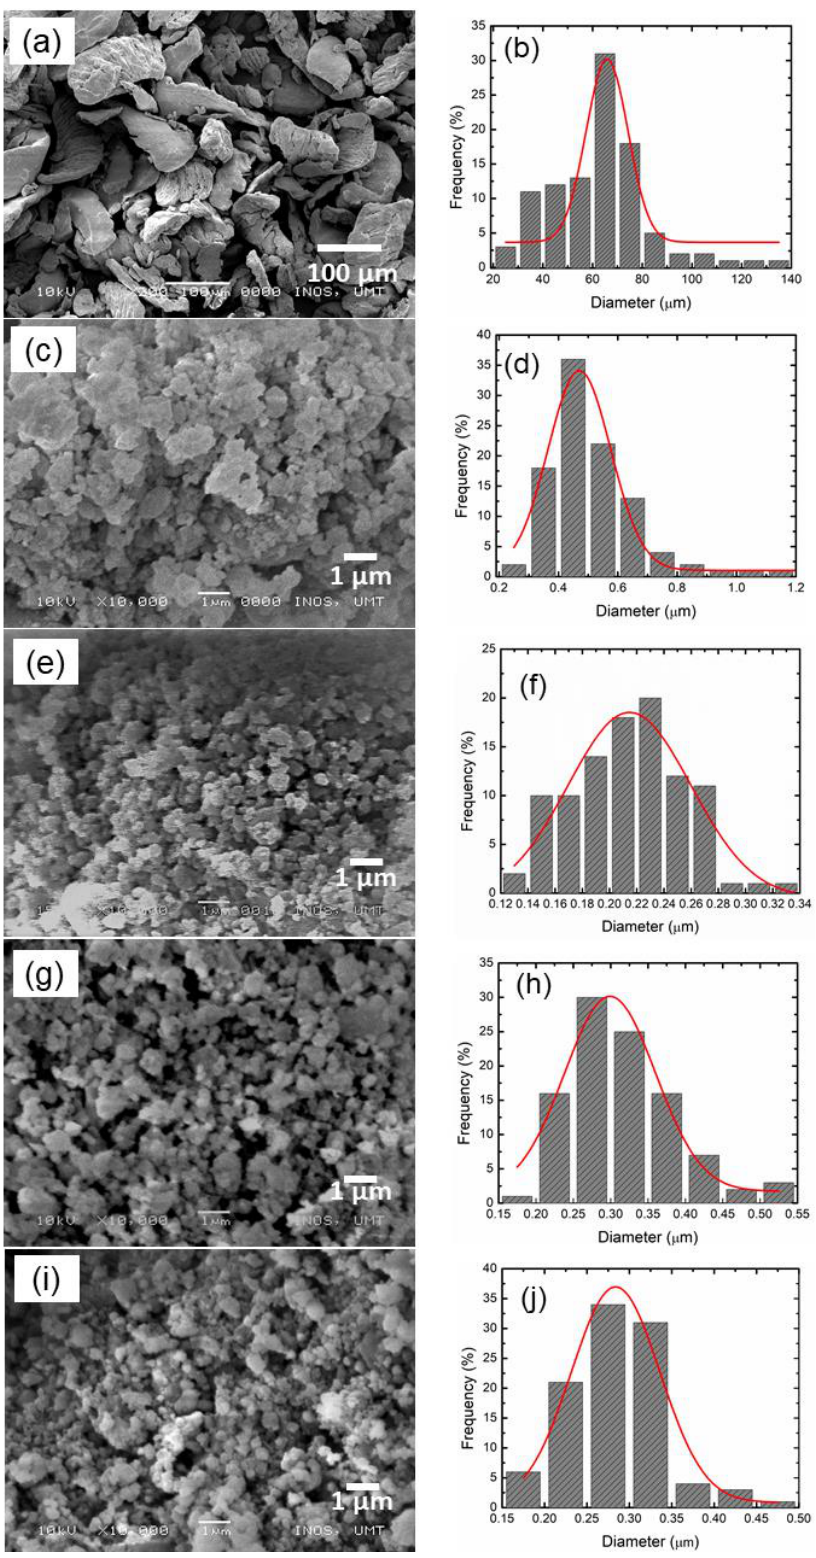
Figure 7. SEM images and particle size distribution histogram of commercial MgH 2 ( a , b ), as-milled MgH 2 ( c , d ), MgH 2 + 10 wt.% CoTiO 3 after milling ( e , f ), MgH 2 + 10 wt.% CoTiO 3 after absorption at 200 °C ( g , h ), and MgH 2 + 10 wt.% CoTiO 3 after desorption at 450 °C ( i , j ).